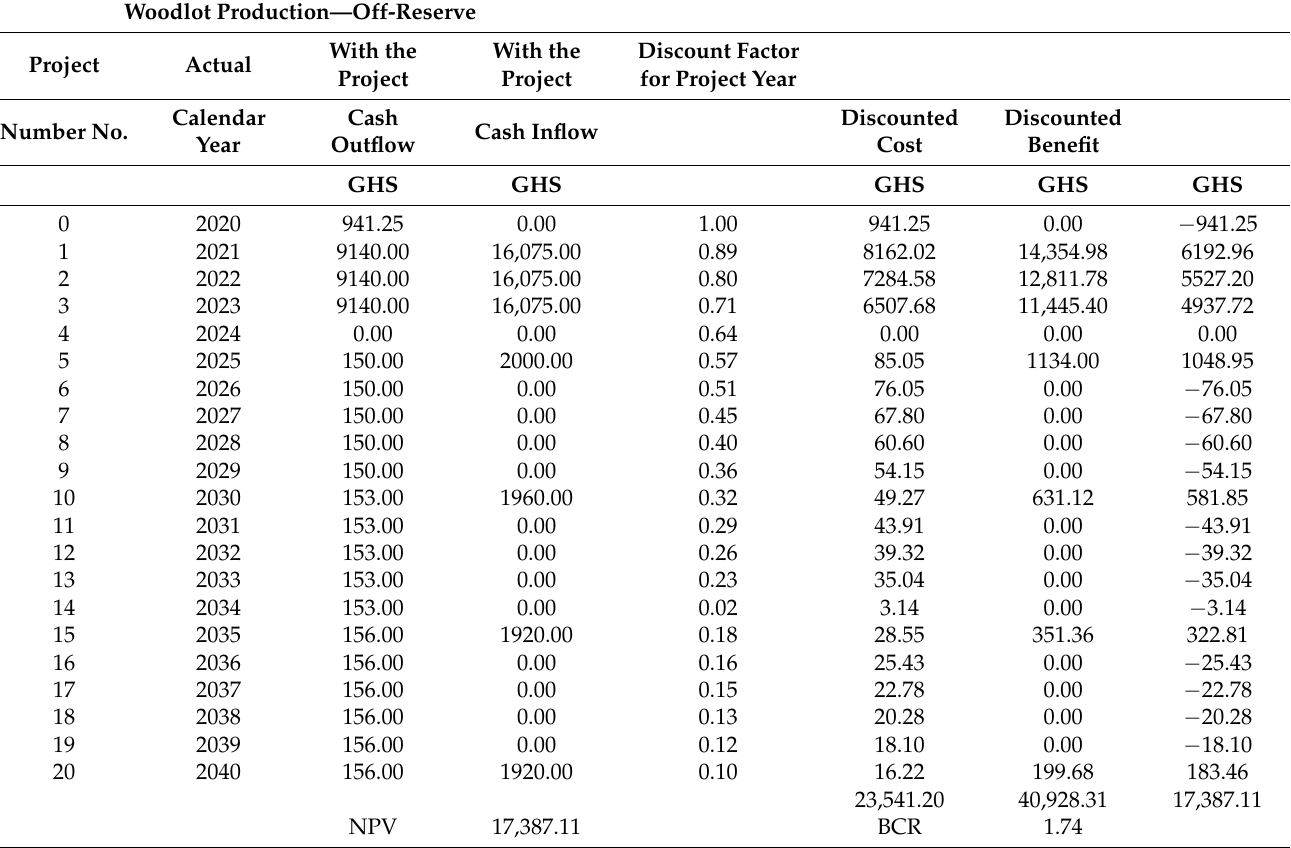
Table A6. Profitability of woodlot farmers (off-reserve).